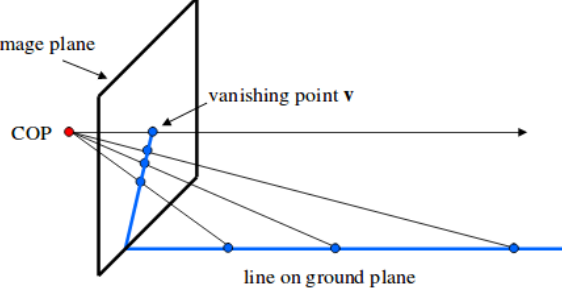
Figure 12. Ground hypothesis assumes all objects are on the floor.